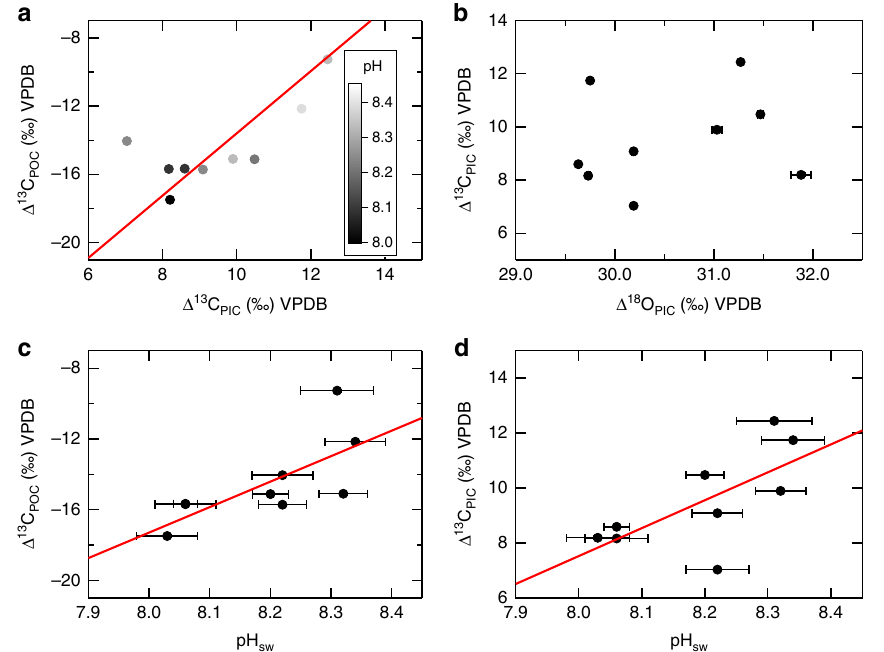
Fig. 3 Stable isotope of carbon and oxygen in O. neapolitana . Comparisons between the carbon isotopic compositions of particulate organic and inorganic carbon ( a ), the carbon and oxygen isotopic compositions of particulate inorganic carbon ( b ), seawater pH and the carbon isotopic composition of particulate organic carbon ( c ), and seawater pH and the carbon isotopic composition of particulate inorganic carbon ( d ). Red lines represent linear regression lines of each panel. Error bars are 1